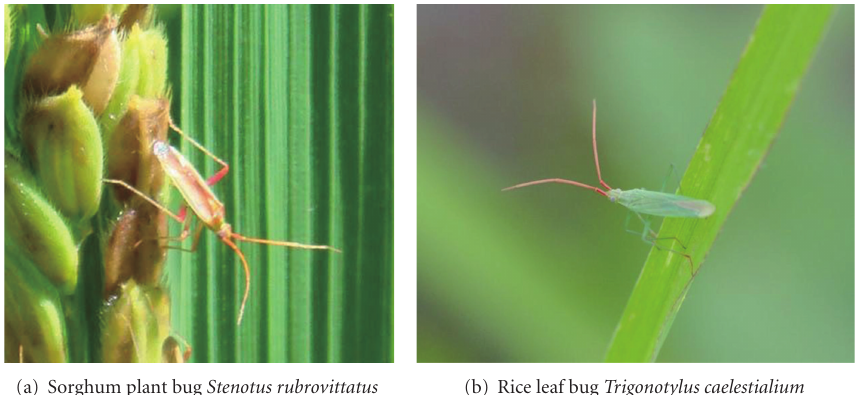
Figure 1: Sorghum plant bug Stenotus rubrovittatus (Matsumura) (a) and rice leaf bug Trigonotylus caelestialium (Kirkaldy) (b) (Heteroptera: Miridae).